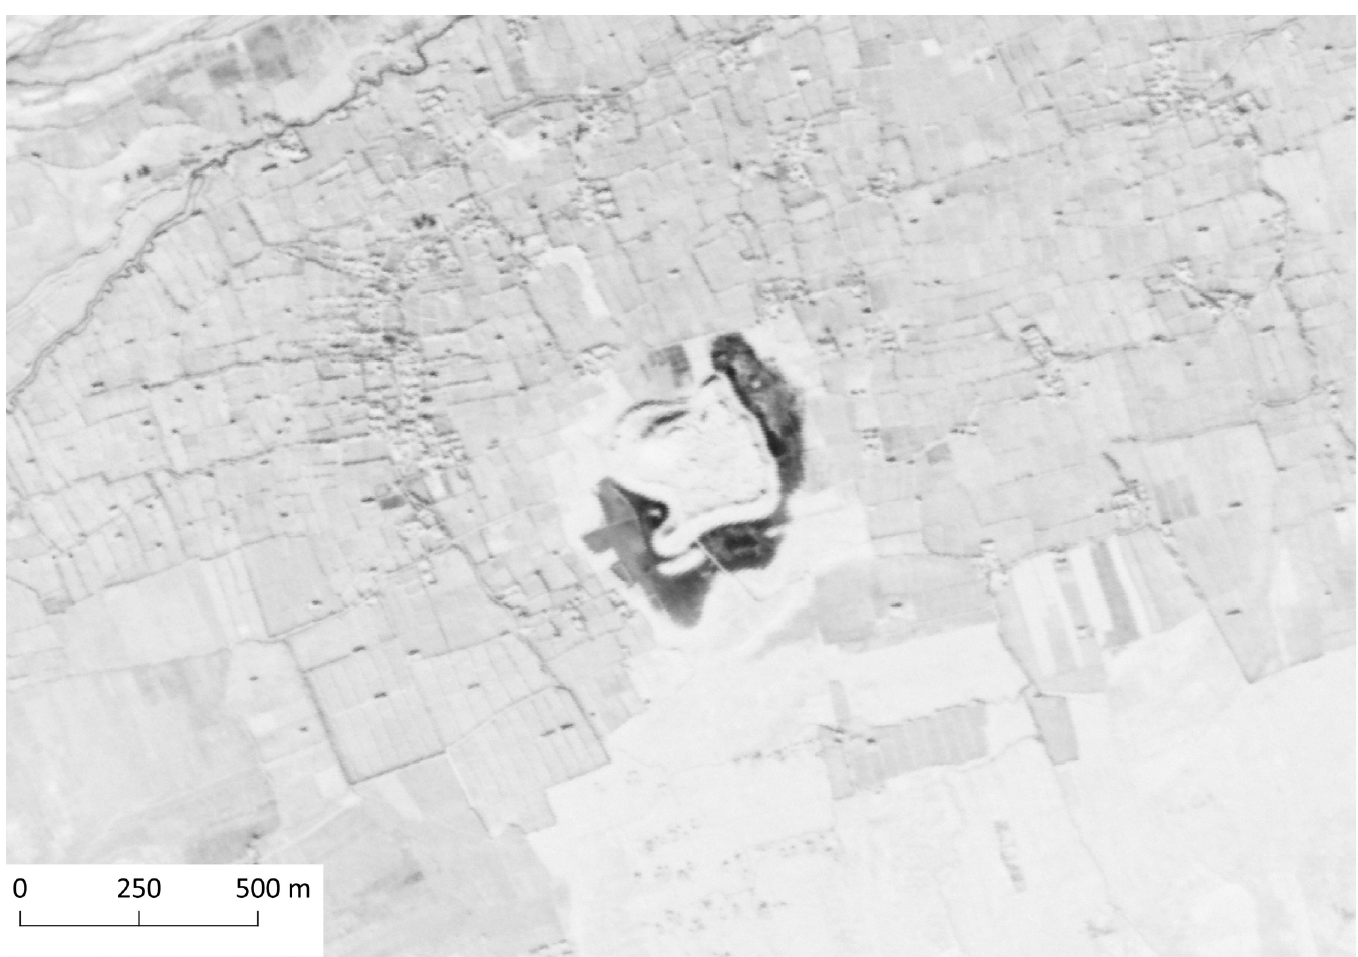
Fig 5. The largest settlement mound in the region, Spirwan. CORONA Satellite image courtesy of the U.S. Geological Survey (DS1108-2234DA032_a, 19.12.1969)